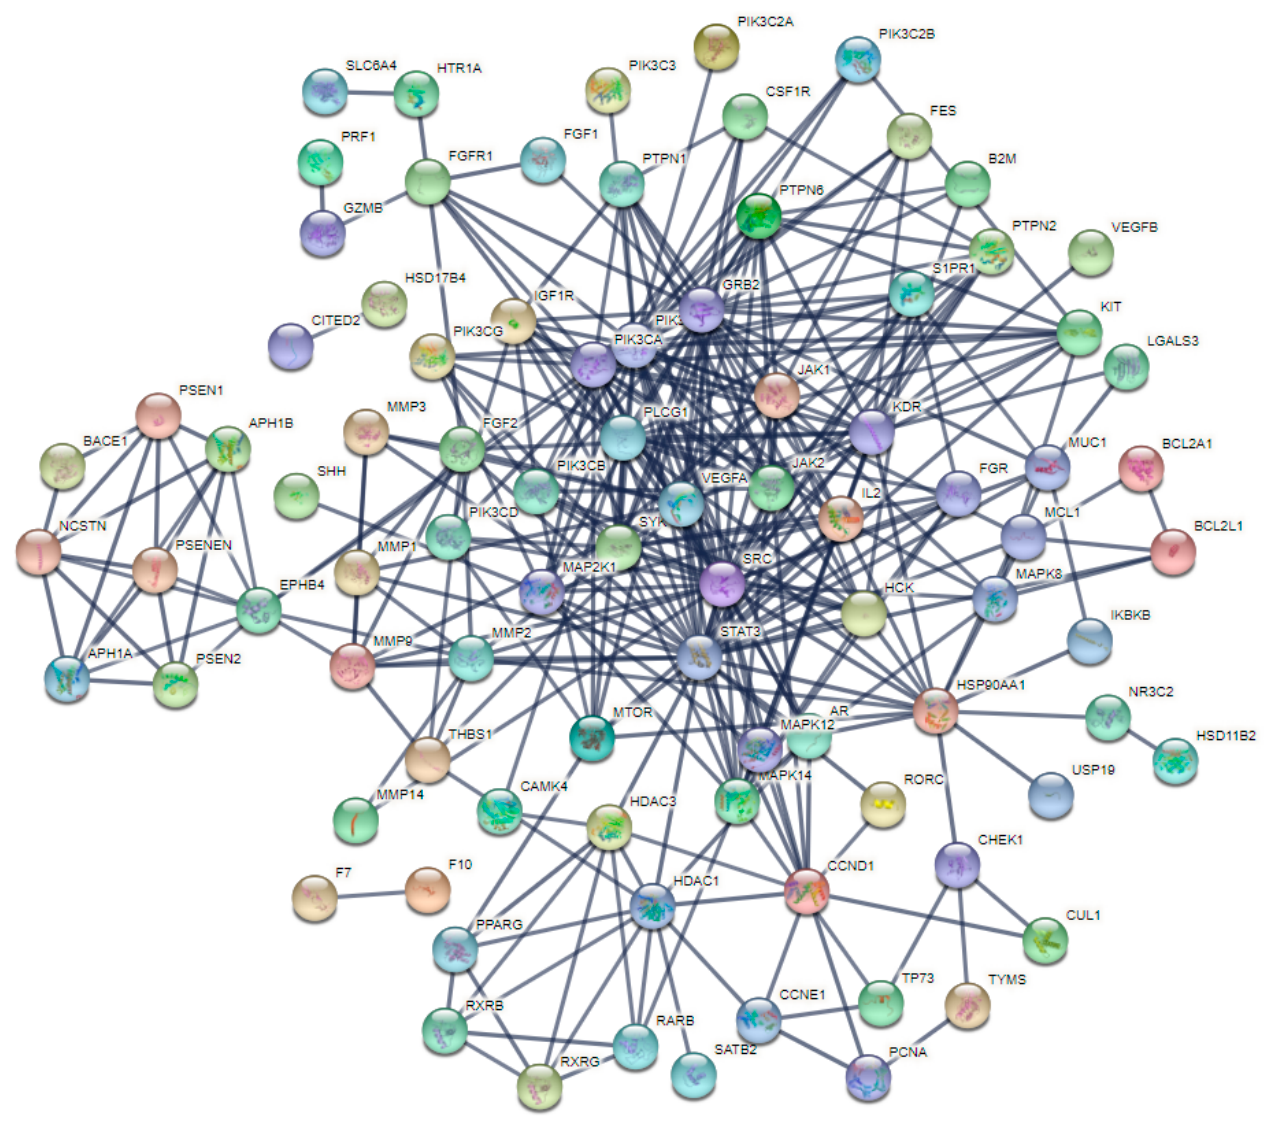
Figure 3. PPI network of the co-targets of GCK–osteoporosis constructed by STRING with the highest confidence score (0.9). Gray lines represent the interactions between the co-target proteins of GCK–osteoporosis, and the colored balls represent the different co-target proteins of GCK–osteoporosis. Table 1. Five central gene clusters of the GCK–osteoporosis PPI network identified based on MCODE